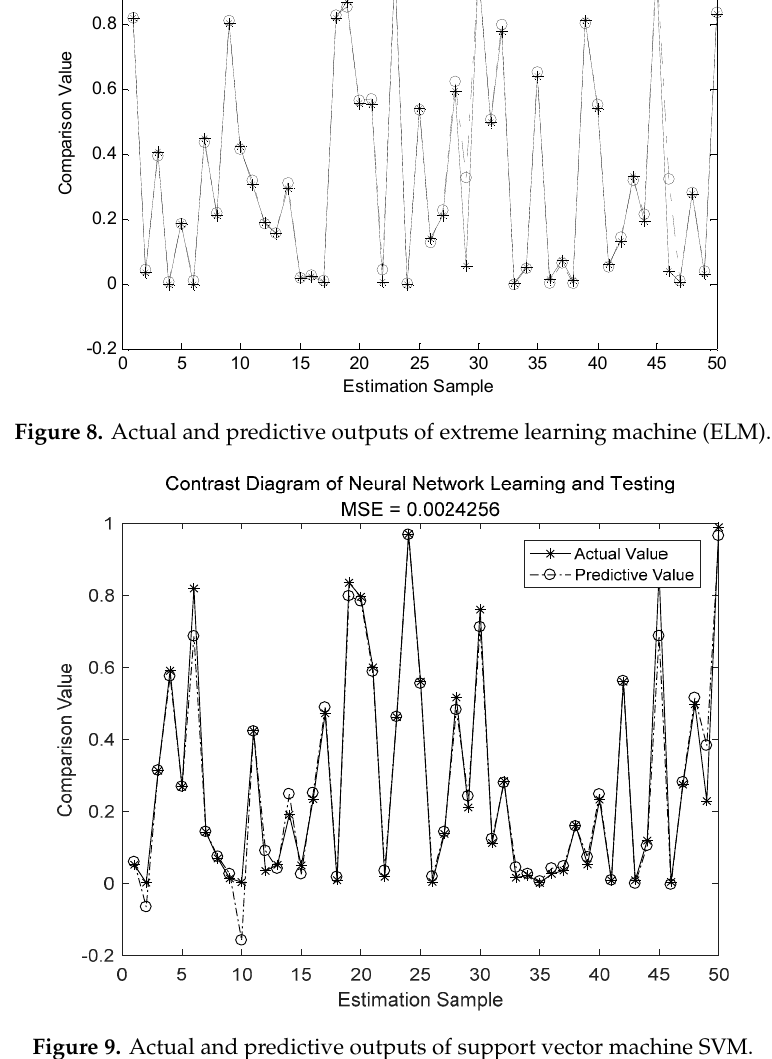
Figure 9. Actual and predictive outputs of support vector machine SVM.